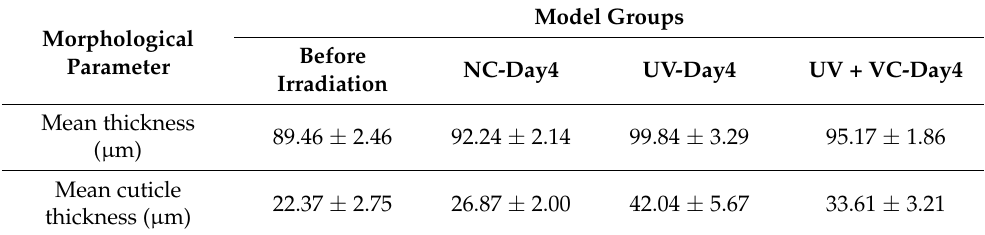
Table 1. Morphological changes in each group of AS before and after UV